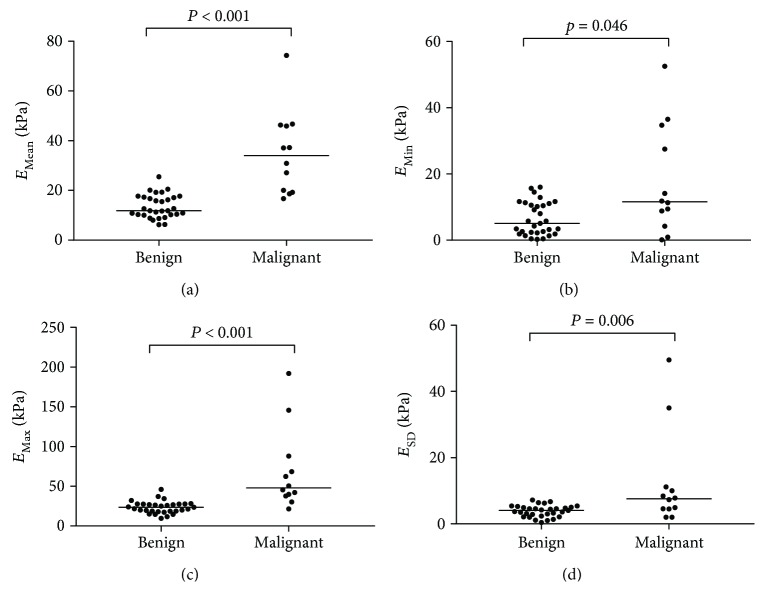
Scatter dot plots of shear-wave elastography measurements for benign (n = 31) and malignant (n = 12) lymph nodes in papillary thyroid carcinoma. (a) Mean elasticity (EMean). (b) Minimum elasticity (EMin). (c) Maximum elasticity (EMax). (d) One standard deviation of elastographic values (ESD). kPa: kilopascal. Central bars denote median.